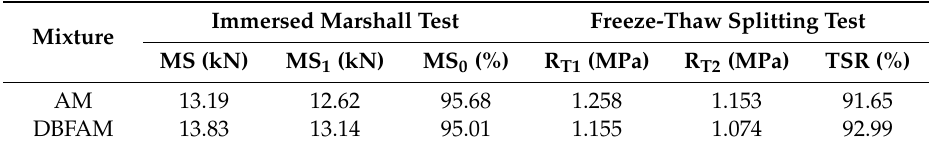
Table 13. Test results of water